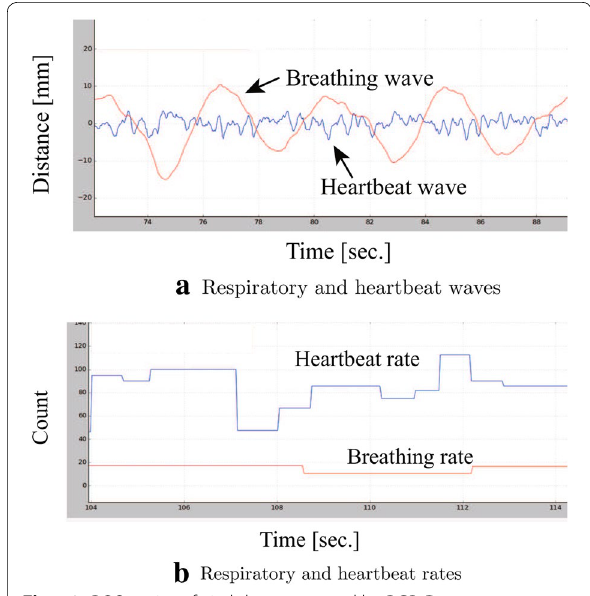
Fig. 19 ROS topics of vital data measured by RGB-D